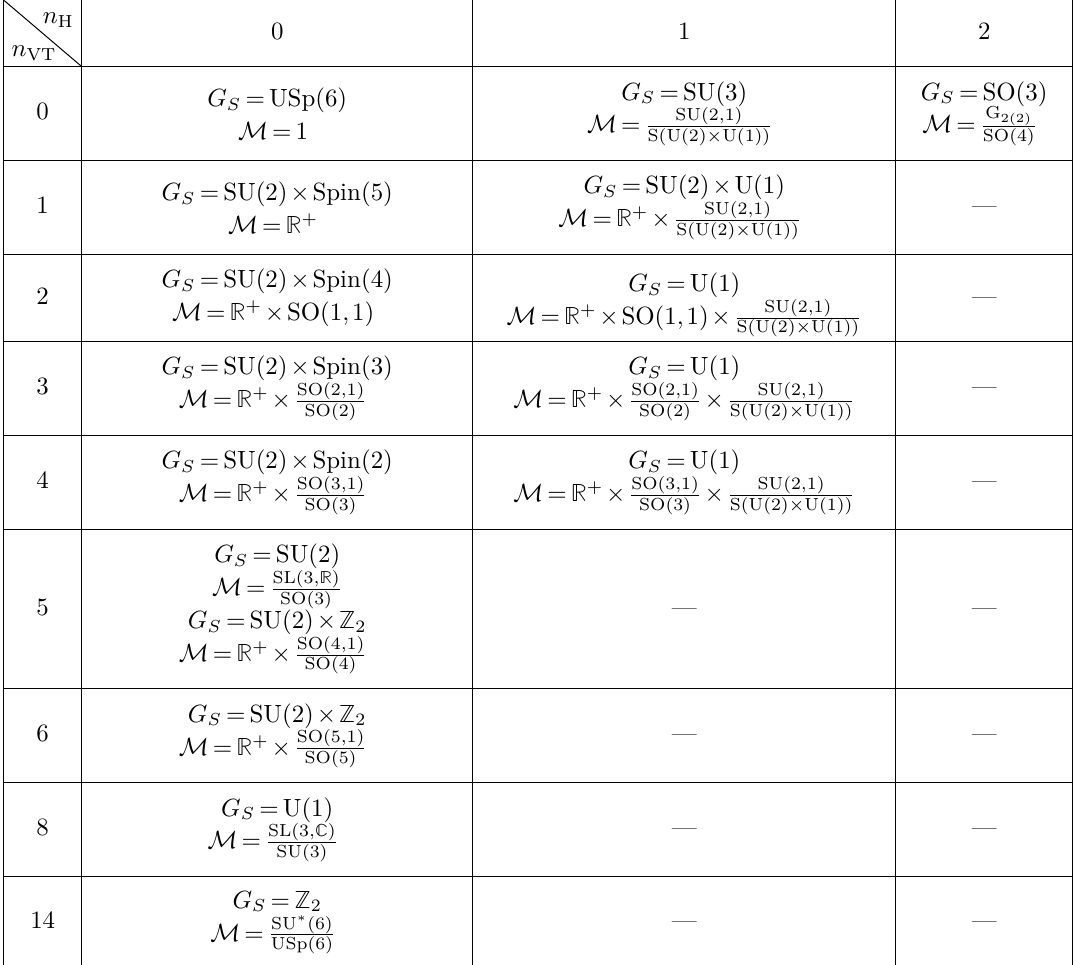
Table 1 . List of all possible consistent truncation with n VT vector/tensor multiplets, n H hypermul- tiplets, and the required G E structure group, as well as the associated scalar manifold M S ⊂ 6(6)